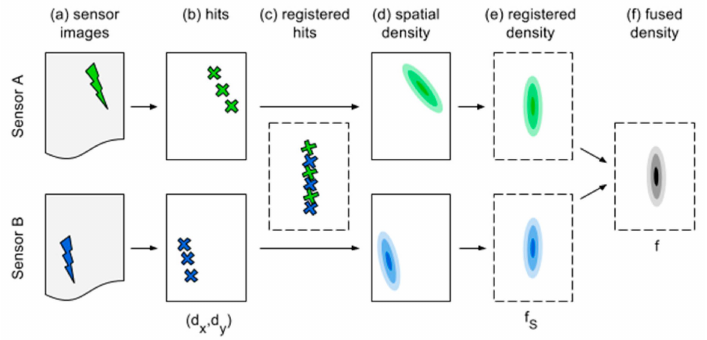
Figure 2. Flow chart of the fusion process. Gray boxes denote original sensor images, each containing an indication (crack symbol). Solid-edge boxes denote local (per sensor) coordinate systems; dashed boxes denote the global (registered) coordinate system. Cross markers denote hits. Two-dimensional spatial densities are indicated by contour plot symbols. Mathematical symbols below the boxes correspond to the notation used throughout this work. ( a ) Sensor images; ( b ) Hits; ( c ) Registered hits; ( d ) Spatial density; ( e ) Registered density; ( f ) Fused